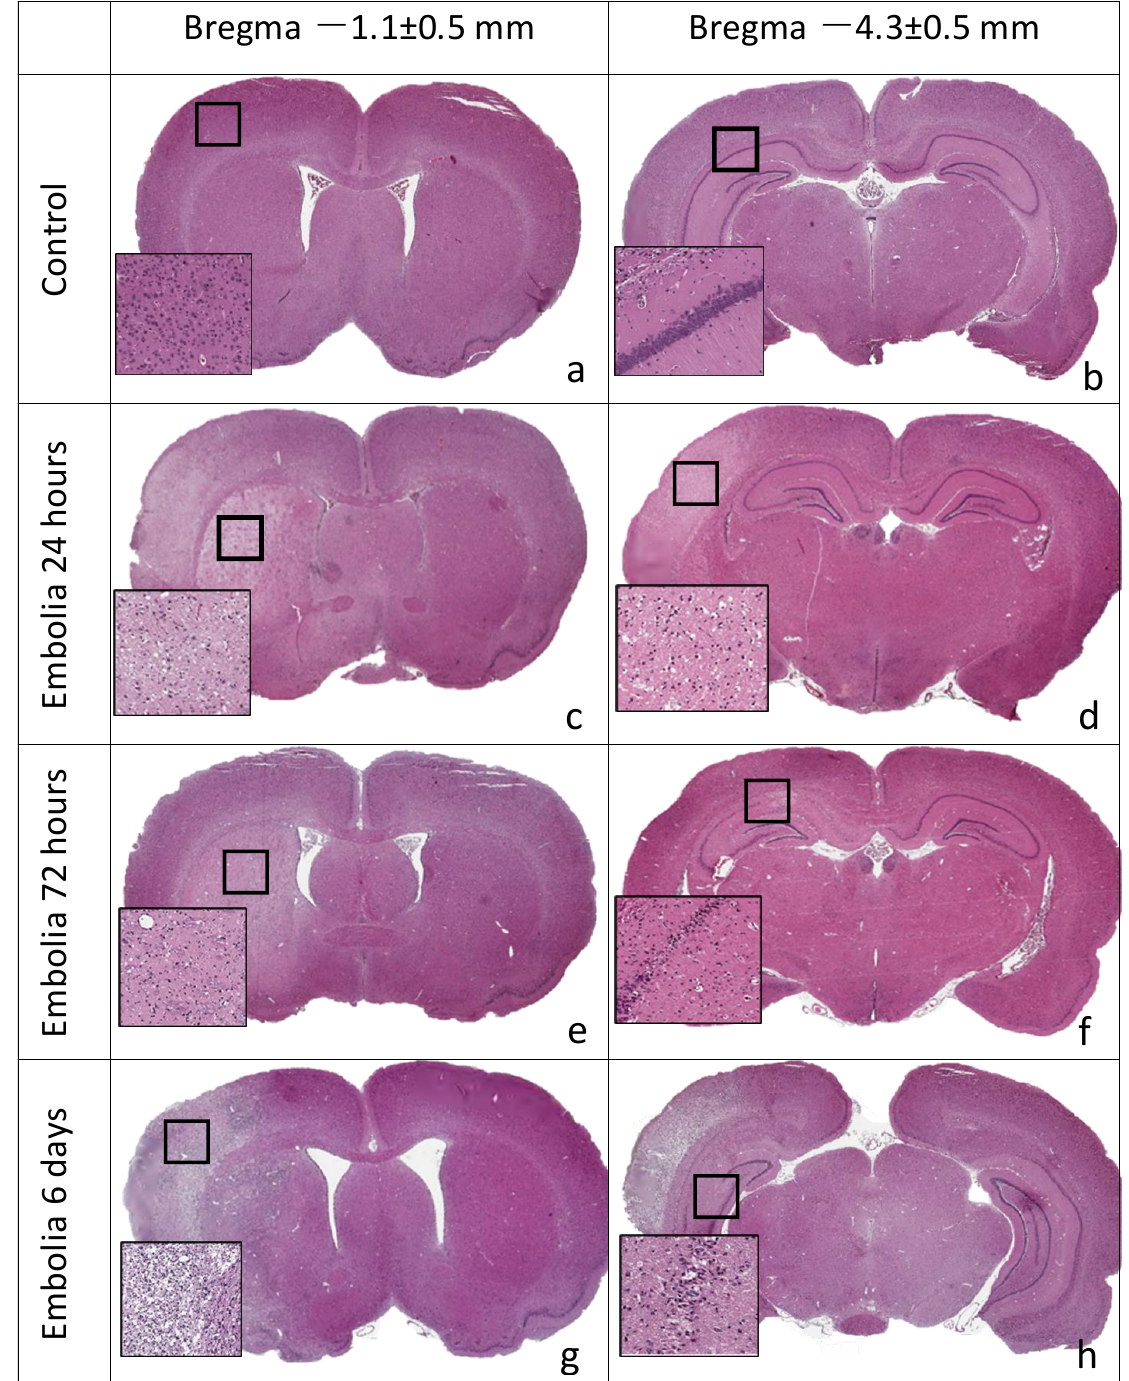
Figure 4. Frontal slices of rat brain, hematoxylin-eosin staining. Ischemic lesions in the territory of the left hemisphere supplied by MCA: striatum, cortex, hippocampus. ( a , b ) Sham control, no areas of damage in the ipsilateral and contralateral cerebral hemispheres. ( c , d ) A total of 24 h after embolization, infarct areas in the striatum and cortex are pale-stained. ( e , f ) A total of 72 h after embolization, infarct areas in the striatum and hippocampus. ( g , h ) A total of 6 days after embolization, infarct areas in the striatum, cortex, hippocampus, and thalamus. Quantitative analysis of hippocampal pyramidal neuron populations revealed a decrease in the density of normal neurons in the CA1 field by 16.8% (n = 7, p < 0.05) 24 h after MCAO, by 26.2% (n = 7, p < 0.05) 72 h later, and by 60.5% (n = 5, p < 0.05) 6 days later vs. group 2, respectively (Table 2). The CA4 field also shows a decrease in the density of normal neurons by 12.6% (n = 4, p < 0.05) after 6 h, by 29.6 (n = 7, p < 0.05) after 24 h, by 9.3% (n = 7, p ≤ 0.1) after 72 h, and by 19.8% (n = 5, p < 0.05) after 6 days vs. the control, respectively (Table 2).